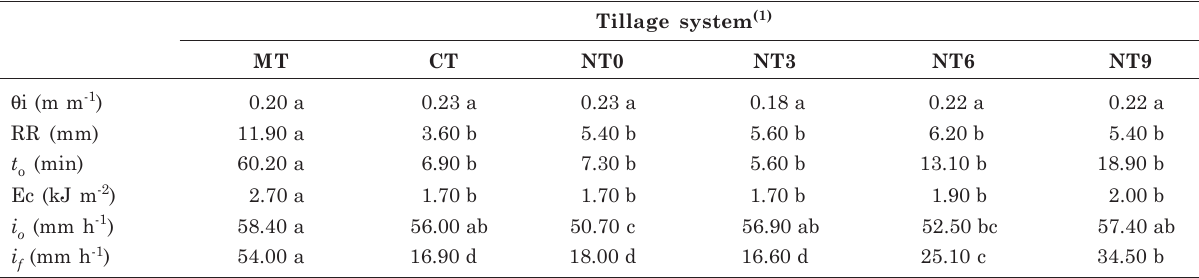
Table 2. Mean values of initial soil moisture ( θθθθθ i), random soil surface roughness(RR), time to the beginning of surface runoff ( t o ), kinetic energy of simulated rainfall (Ec) and of the rates of initial infiltration ( i o ) and final infiltration ( i f